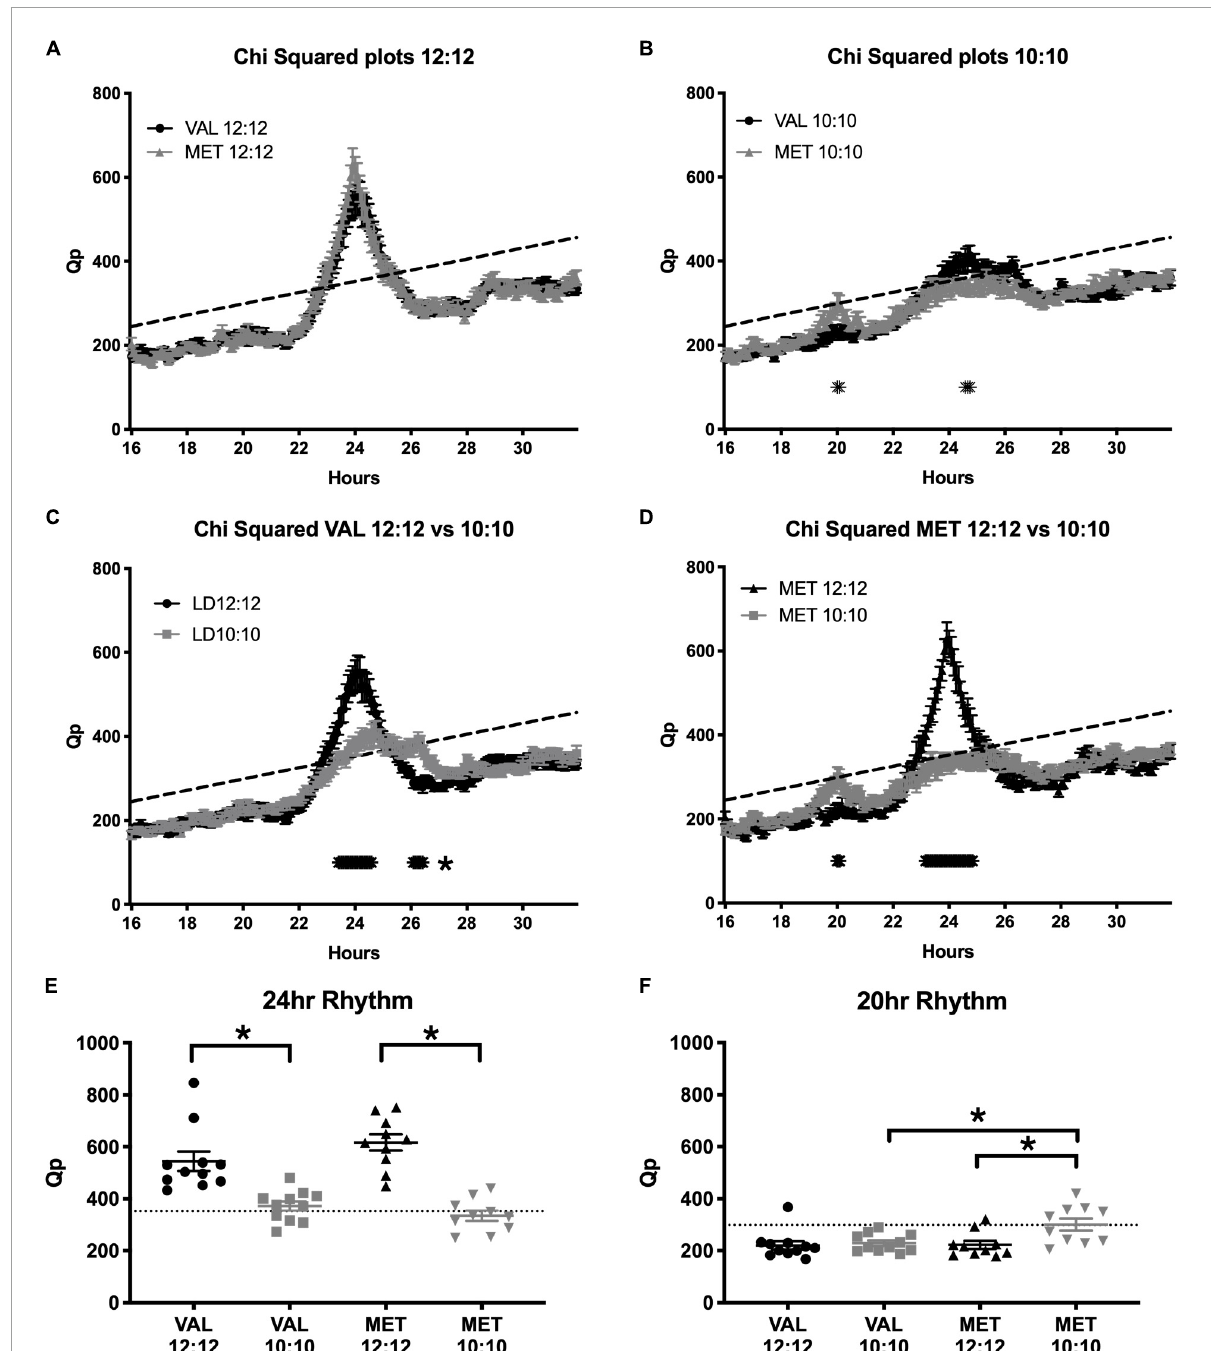
FIGURE6 Met mice show a stronger period adaptation to ECD than do Val mice. Graphs show Chi-squared values during baseline LD12:12 conditions and after 20 days in LD10:10 ECD. During the baseline recording (A) , there was a robust locomotor rhythm centered on 24 h in both Val (black line) and Met (gray line) animals. After 20 days in ECD (B) , Met mice had a higher Qp value around a 20 h rhythm, and Val mice had a higher Qp value around a 24 h rhythm. When comparing rhythms between the control (LD12:12; black line) and ECD (LD10:10; gray line) cycles, Val mice (C) had a less robust rhythm at 24 h, and had a longer period around 26 h. Met mice (D) had a higher Qp value around a 20 h period in a LD10:10 cycle, and a blunted 24 h rhythm. Qp values from a 24 h rhythm (E) were above the significance line for all Val and Met mice in a LD12:12 cycle, while only 7/11 Val mice and 3/10 Met mice were above the significance line. Qp values from a 20 h rhythm (F) were above the significance line in 1/11 Val mice and no Met mice in a baseline conditions, while 1/11 Val mice and 5/10 Met mice were above the significance line in ECD. * p <